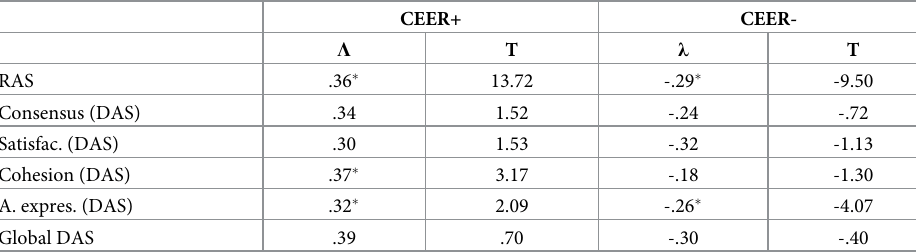
CEER + = Positive Couples Extrinsic Emotion Regulation; CEER - = Negative Couples Extrinsic Emotion Regulation; RAS = Relationship Assessment Scale; DAS = Dyadic Adjustment Scale; Satisfac. = Satisfaction; A. expres. = Affectional expression; λ = standardized factor loadings; t = Student t (values over 2.58 are significant with a confidence level of 99%). � p < .01.